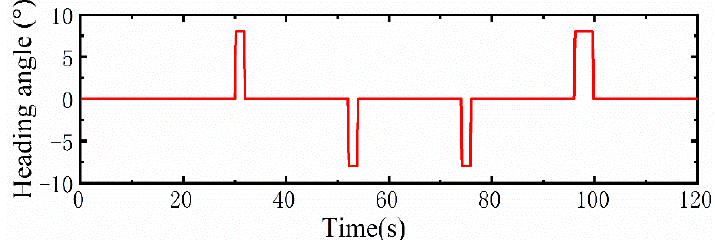
Figure 10. Vehicle heading angle information.